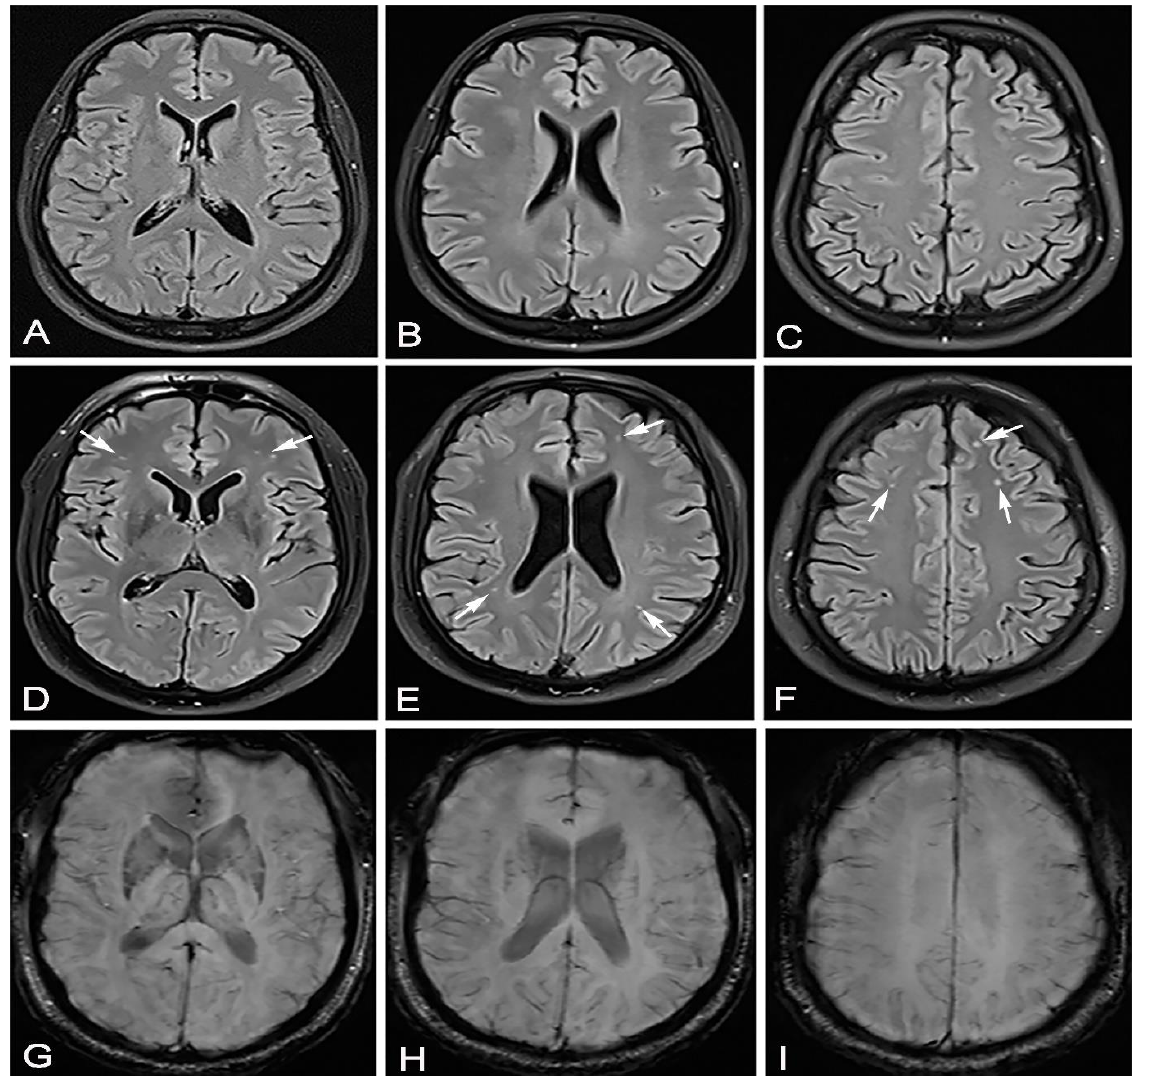
Figure 2. In June 2020, this male patient — as in Figure 1 — had a completely normal brain MRI after vertigo ( A – C ). In March 2021, 53 days after recovering from moderate SARS-CoV-2 infection, the same patient came for a brain MRI due to headache, vertigo and taste and smell disorder. Brain MRI showed hyperintensive lesions on the FLAIR sequence located mostly bilaterally frontally subcortically and bilaterally periventricularly ( D – F ) (white arrows). The same transverse cross sections of the FLAIR sequence as on ( A – C ), without signs of microhemorrhage on the SWI sequence ( G – I ).